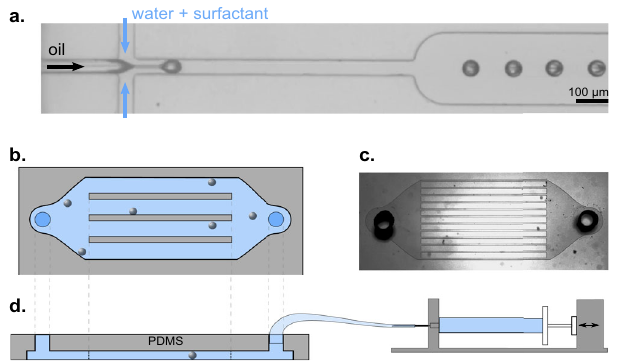
Fig. 6 Micro fl uidics. a micrograph of the fl ow focusing geometry for droplet generation. b – d Microchannel geometry setup: ( b ) Top view schematic of the used channel structure, c micrograph of the channel structure (channel width 100 μ m), ( d ) side view schematic of the PDMS structure with connected syringe